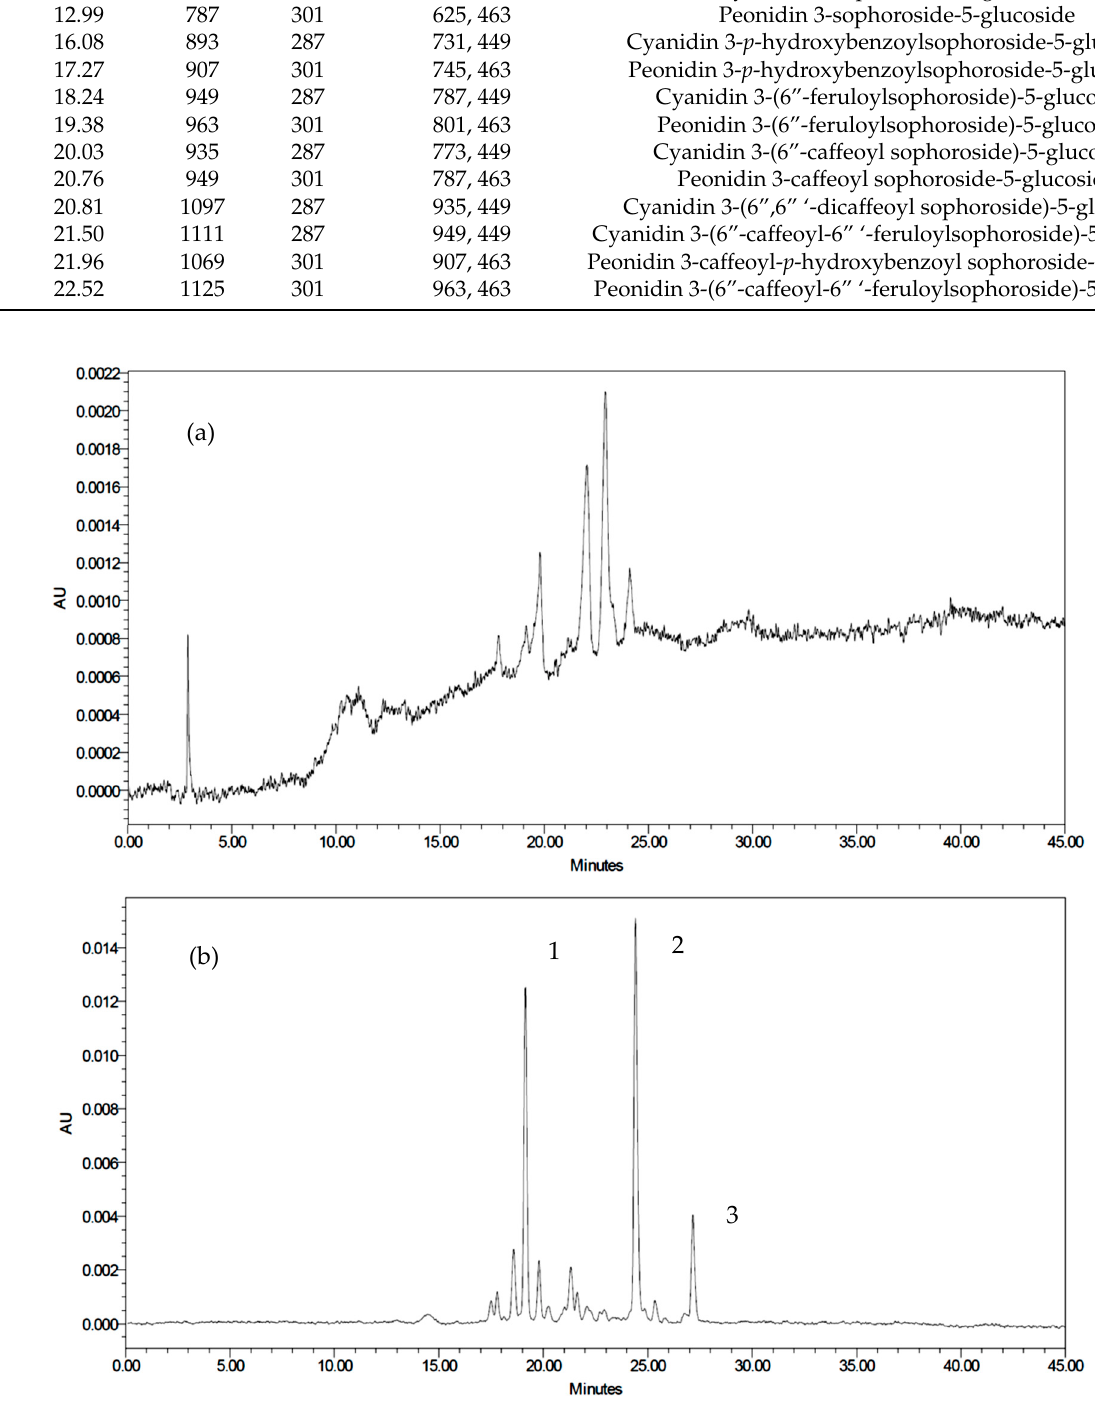
Figure 8. Typical ( a ) anthocyanin and ( b ) anthocyanidin HPLC profiles of the PSPP. Table 7. Anthocyanins in PSPP using different method of analysis.